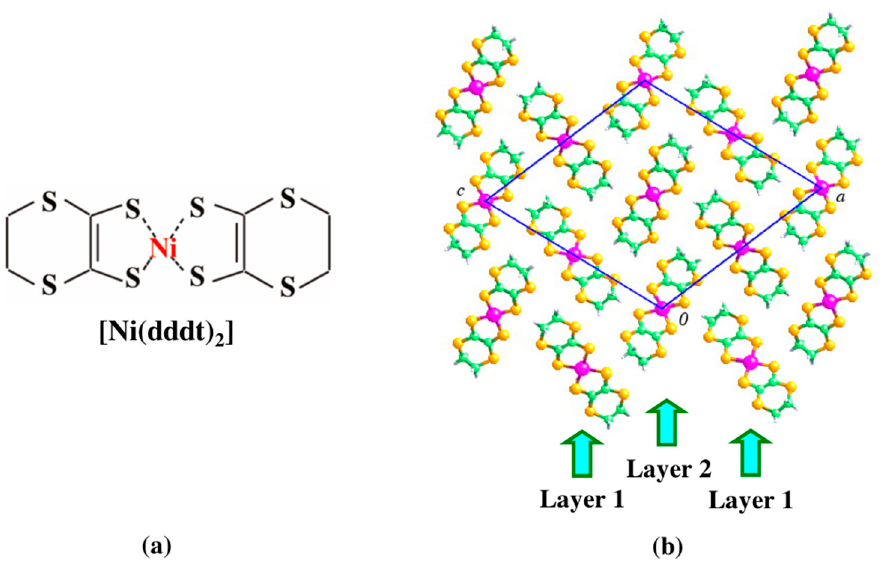
Figure 1. ( a ) Molecular structure of [Ni(dddt) 2 ], and ( b ) its crystal structure viewed down the b axis, highlighting the crystallographically-independent layers 1 and 2. Ni, C, H and S are shown in magenta, green, grey and yellow, respectively.